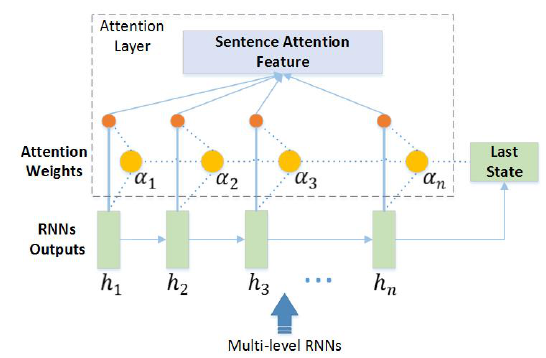
Fig. 2 Architecture of the attention layer. Fig. 3 Architecture of the tensor